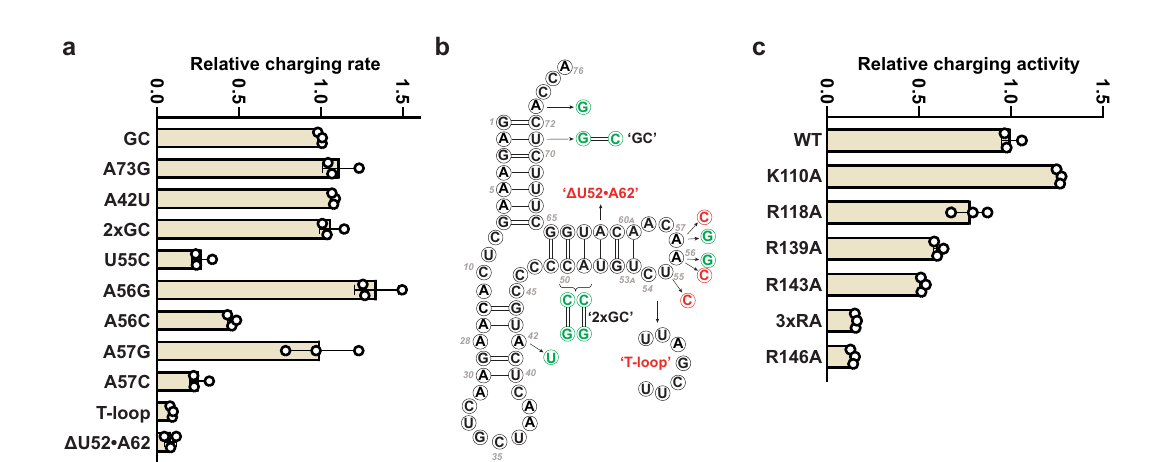
Fig.5|MutationalandkineticanalysisofthemSerRS-mtRNA Ser(GCU) interaction. a Summary of charging experiments for mtRNA Ser(GCU) mutants by wild-type mSerRS. b Summary of mtRNA Ser(GCU) mutants used in a . ‘ GC ’ denotes stabilized ‘ wild-type ’ tRNA(seeSupplementary Fig. 4 and “ Methods ” ). c Charging kineticsfor